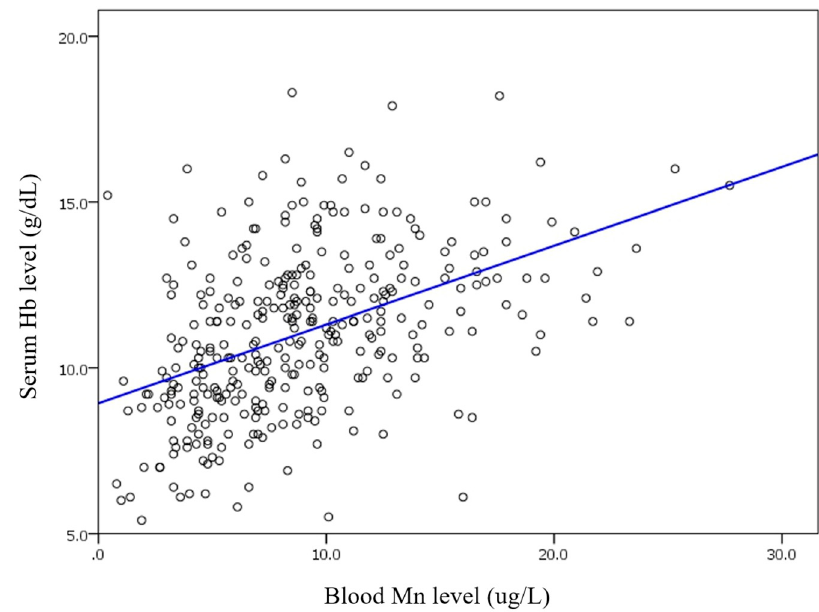
Figure 3. Blood Mn and serum hemoglobin (Hb).